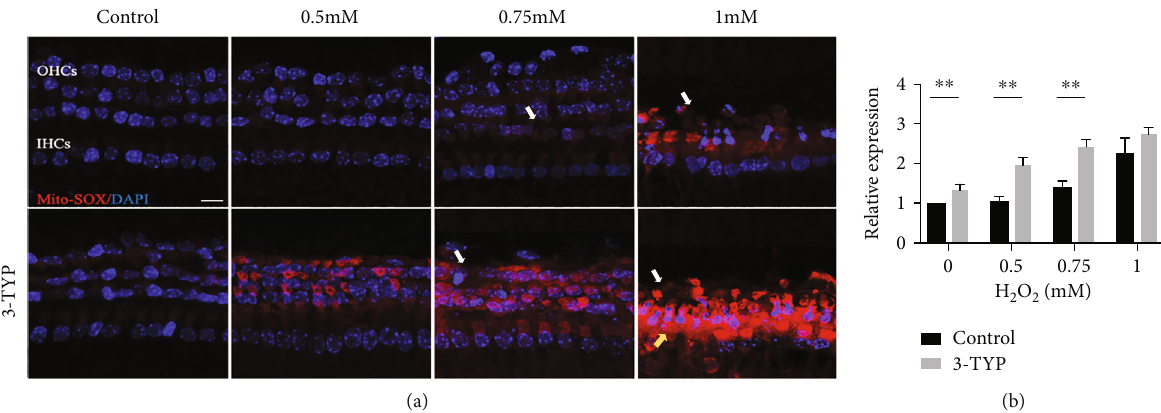
Figure 3: H O induces ROS generation, which is enhanced by 3-TYP. (a) Confocal images of MitoSOX staining (red) in the 0, 0.5, 0.75, 2 2 and 1 mM groups pretreated with or without 3-TYP. The white arrows indicate OHC damaged areas. Yellow arrows indicate IHC damaged areas. (b) Relative level of fl uorescence intensity in each group. Data are expressed as means ± SD ( n = 5 organ of Corti per concentration). ∗ P < 0 : 05 , ∗∗ P < 0 : 01 , and ∗∗∗ P < 0 : 001 . Scale bar = 10 μ m.